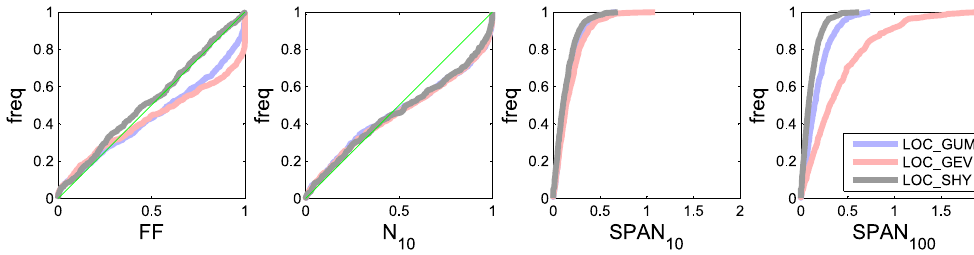
Fig. 1. Reliability ( FF , N 10 ) and stability (SPAN 10 , SPAN 100 ) indices for local